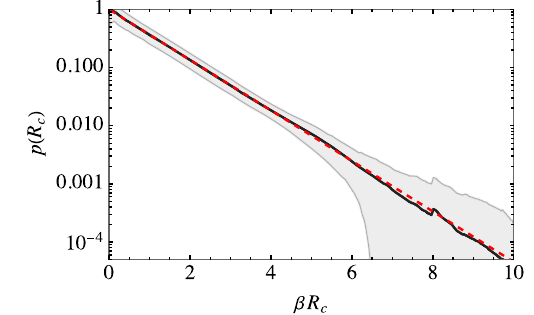
Fig. 2 Probability distribution function of bubble radius at collision. The red dashed curve shows the analytical result (15). The black curve and the gray band show the mean and the variance of the result from our numerical simulations of bubble nucleation